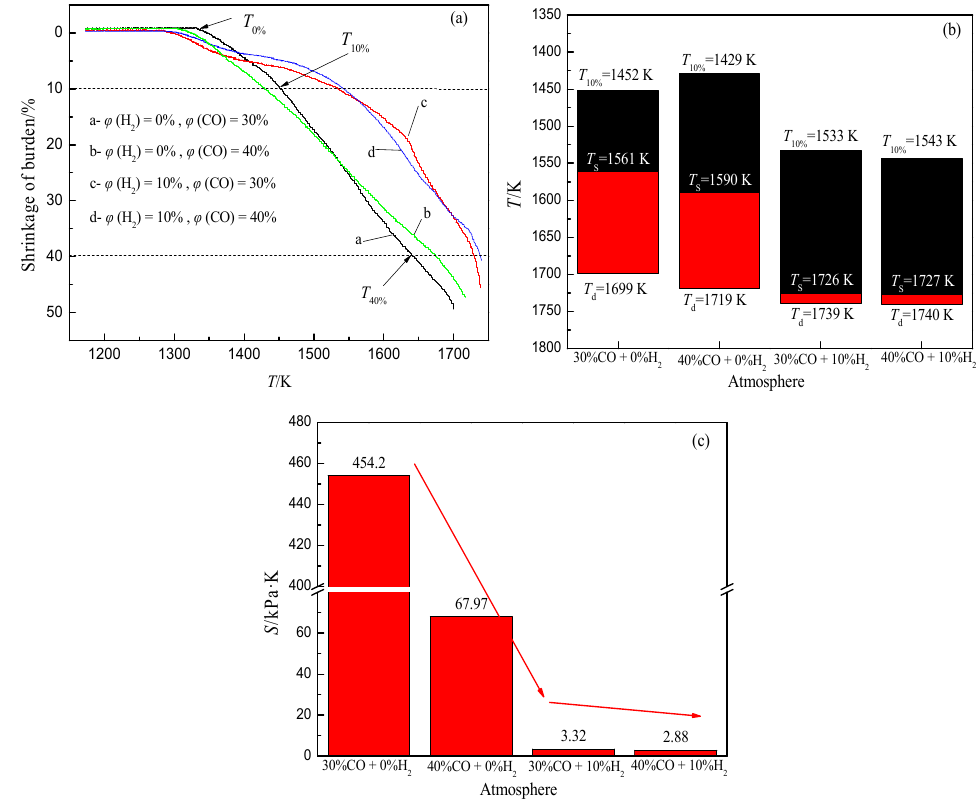
Figure 8. Change of softening-melting property of burden, adopted from [72], with permission from Elsevier, 2020. ( a ) Relationship between shrinkage and temperature; ( b ) Characteristic temperature of cohesive zone; ( c ) Permeability index of cohesive zone under different atmospheres.